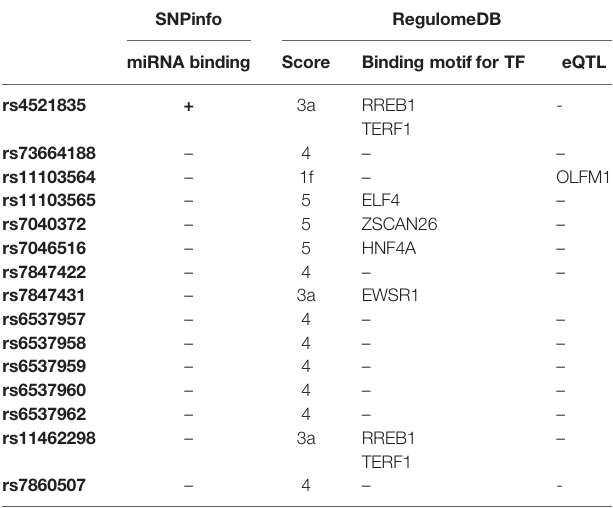
TABLE 7 | In silico prediction of functional role of analyzed genetic